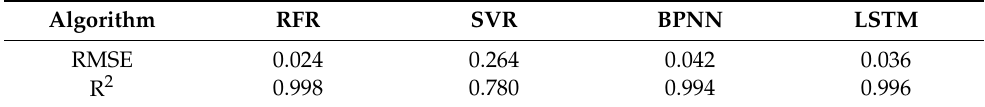
Table 1. Forecasting index of each algorithm on smooth time sequences.